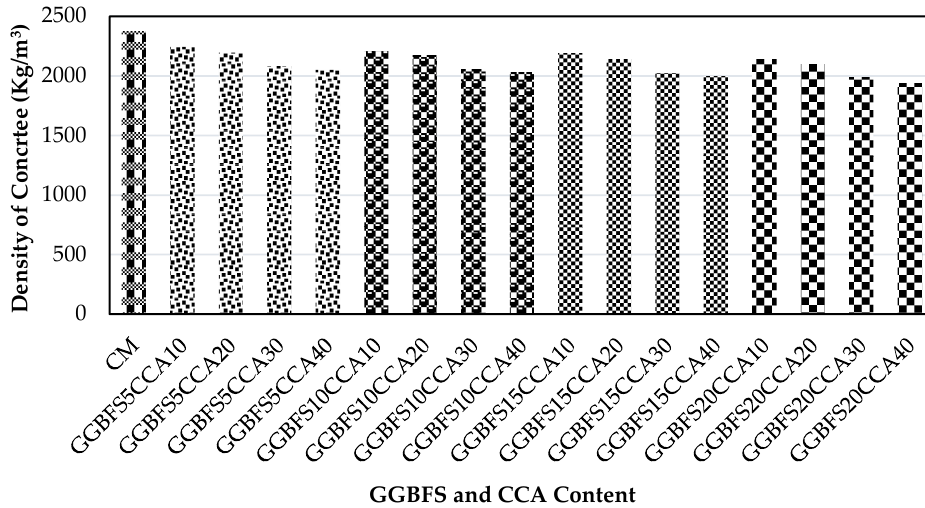
Figure 8. Density of concrete containing GGBFS and CCA.